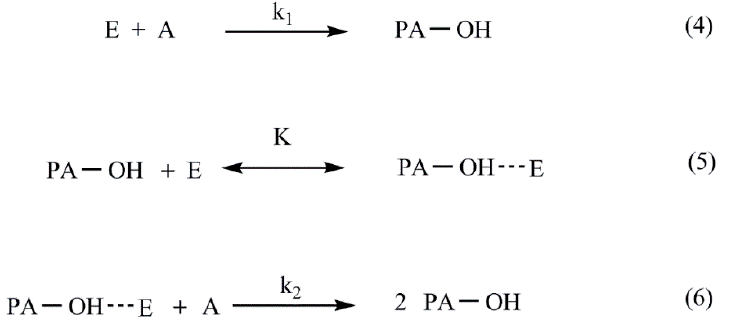
Figure 6. Simplified kinetic model for epoxy/amine reactions (1) and (2).